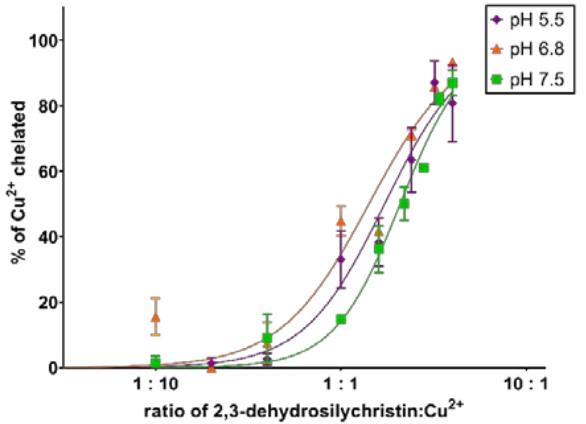
Figure 2. Chelation of cupric ions by 2,3-dehydrosilychristin using hematoxylin method. Data show the measurement after 5 min.